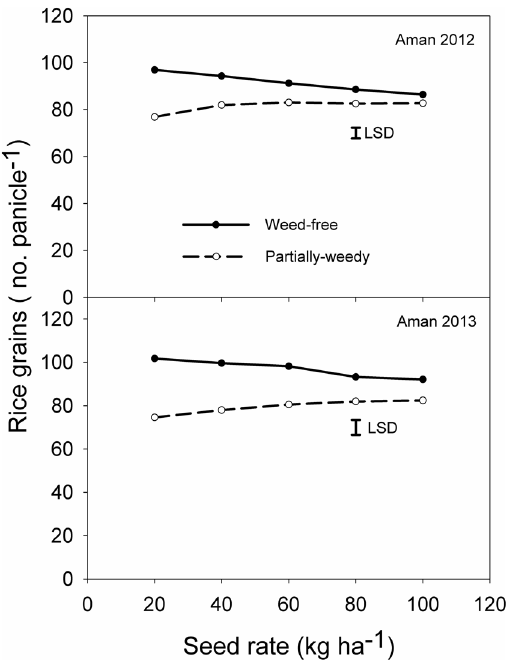
Figure 7. Effect of rice seeding rate and weed infestation level on rice grain yield (t ha 2 1 ) in 2012 and